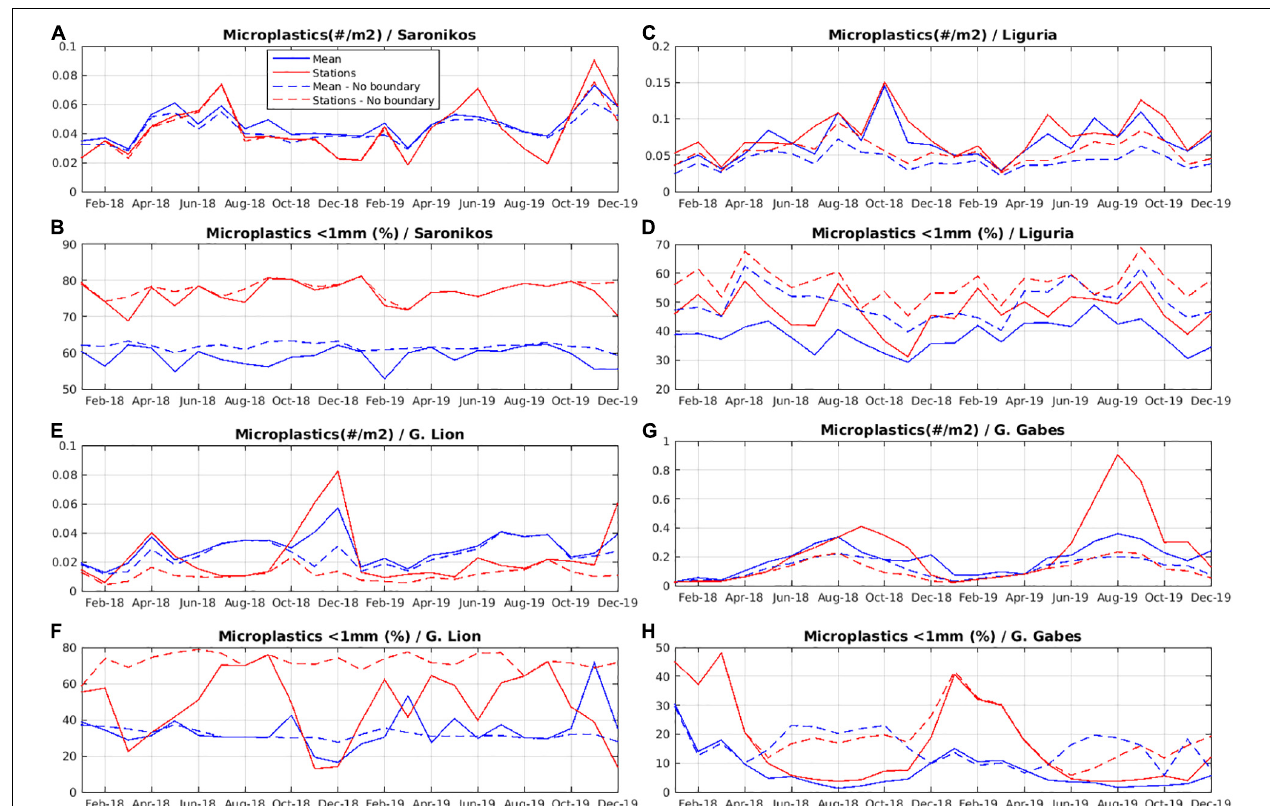
FIGURE 11 | Variability over 2018–2019 period of microplastics concentration (items/m 2 ) and microplastics < 1 mm (%), averaged over the model domain (blue lines) and the stations area (red lines), in the reference simulation (solid lines) and a simulation without input of MPs along the open boundaries (dashed lines), in (A,B) Saronikos Gulf, (C,D) Ligurian Sea, (E,F) Gulf of Lion, and (G,H) Gabes